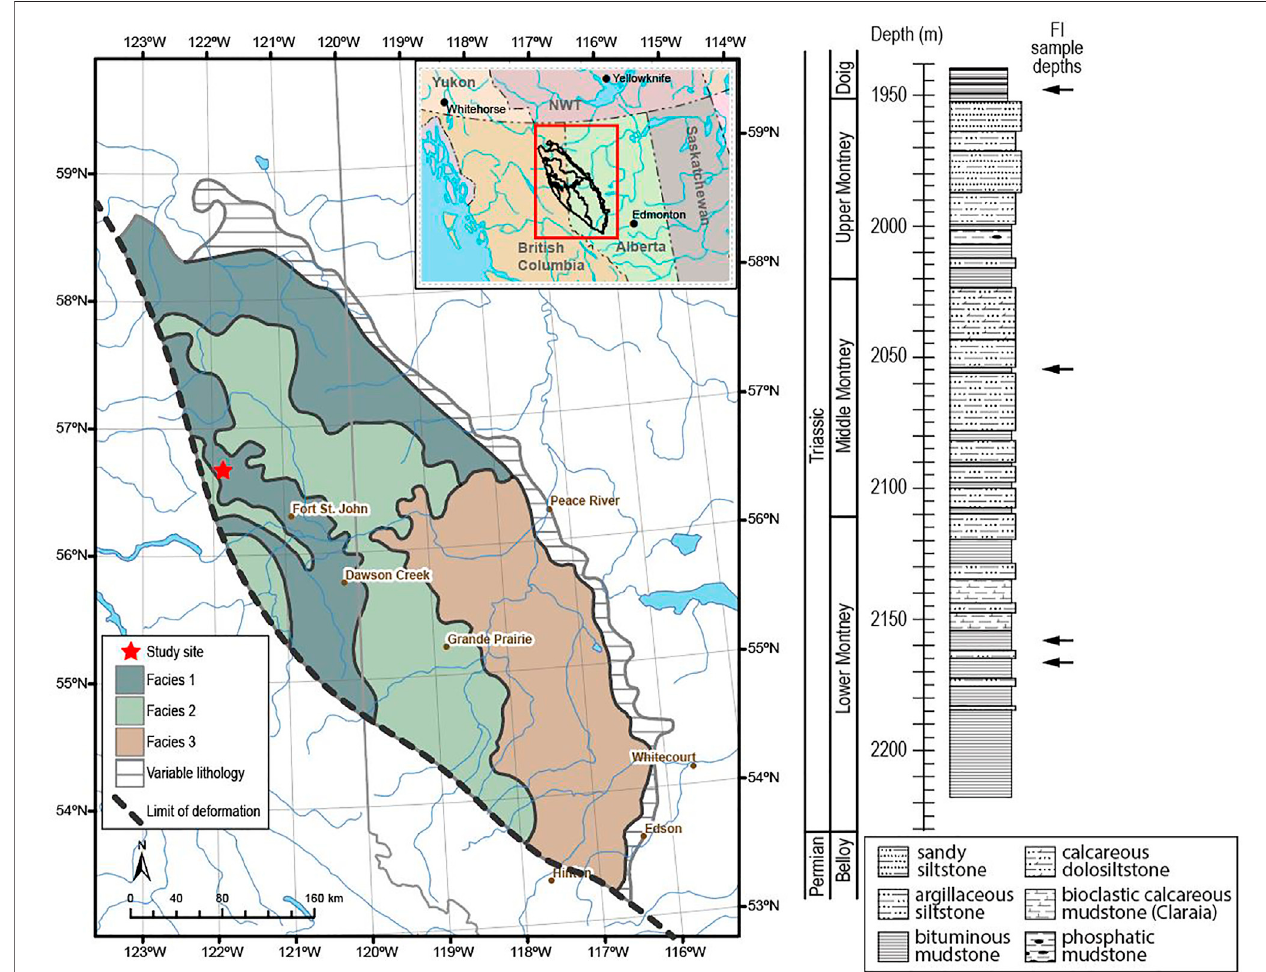
FIGURE1| StudySiteandwellstratigraphy.Studysiteshownasredstaratapproximately122 ° Wand56.75 ° N.MontneyfaciesdistributionadaptedfromWestern CanadianSedimentaryBasinAtlas(Edwardsetal.,1994);Facies1:shalewithsiltstone;Facies2:siltstoneslightlysandy;Facies3:interbeddedsandstoneandsiltstone. Core stratigraphy adapted from Laycock et al. (2021). Depth of fl uid inclusion samples shown by arrows.